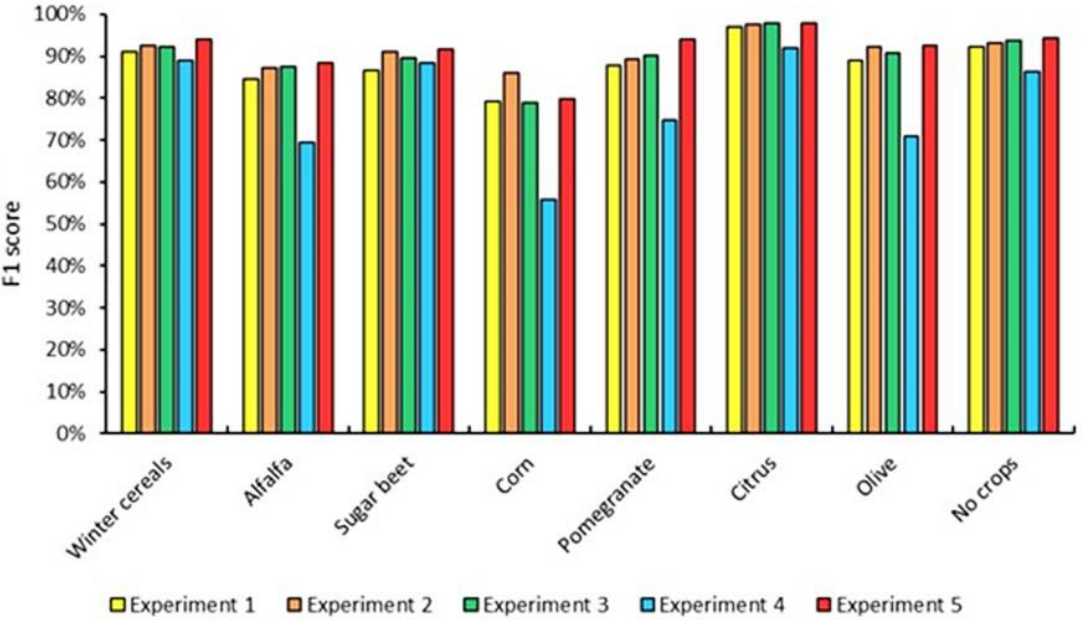
Figure 15. F1 score of TIP crops as a function of experiments.